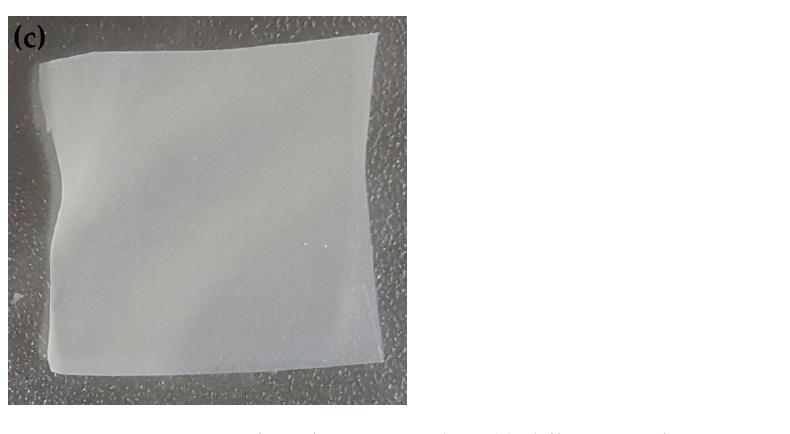
Figure 4. FTIR spectra of CO/PHBD PU 8h at ( a ) different CO/PHBD ratios and ( b ) different NCO/OH ratios; ( c ) image of CO/PHBD PU 8h.